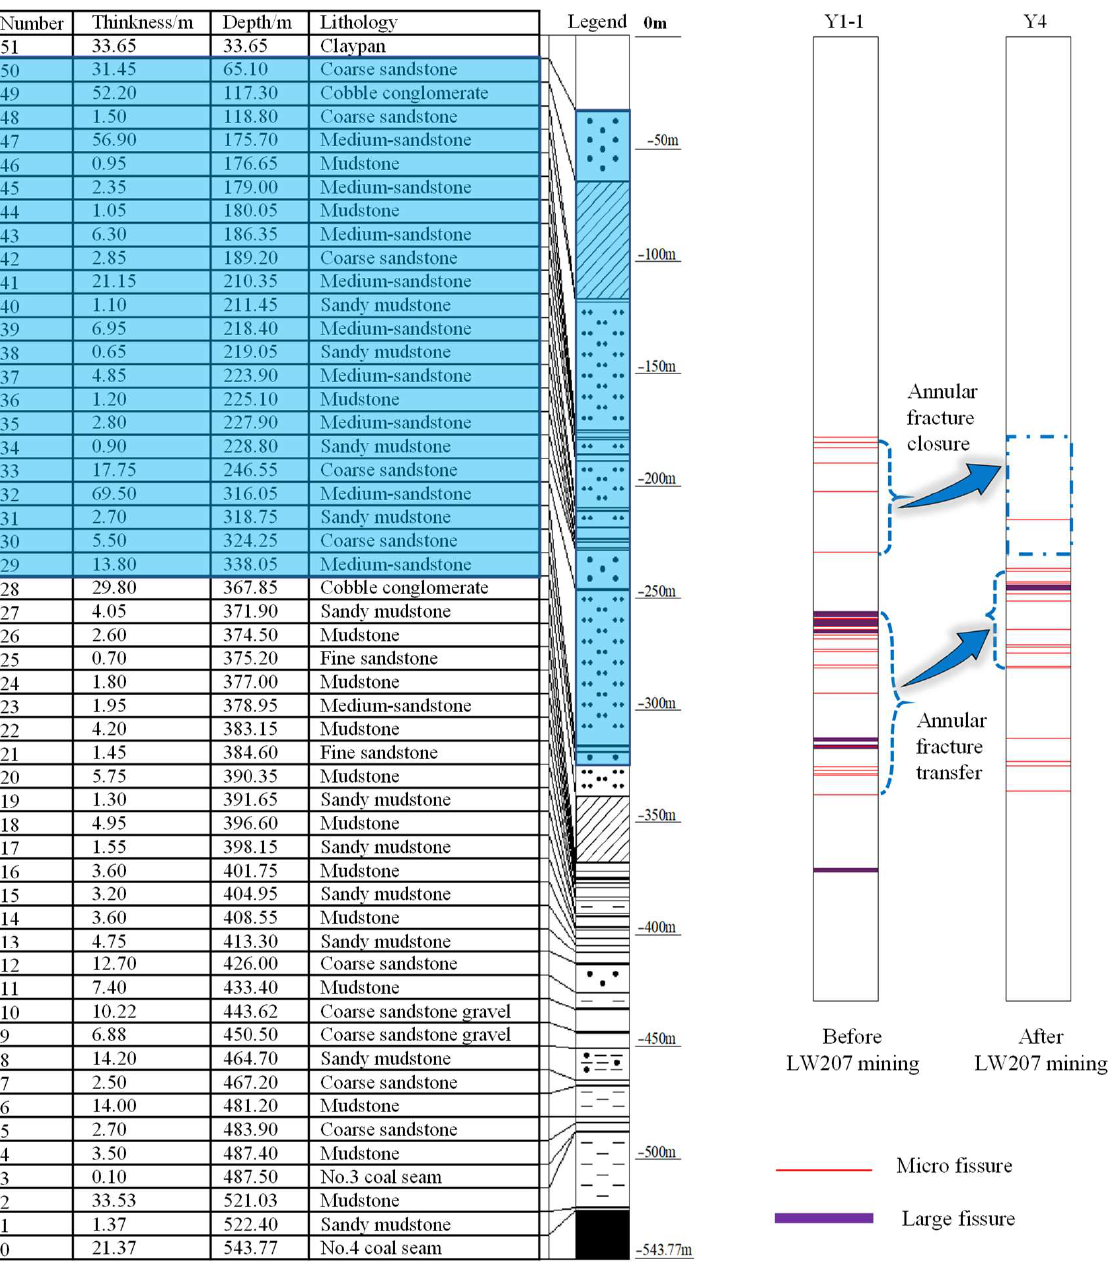
Figure 12. Statistics of the borehole fracture distribution horizon.